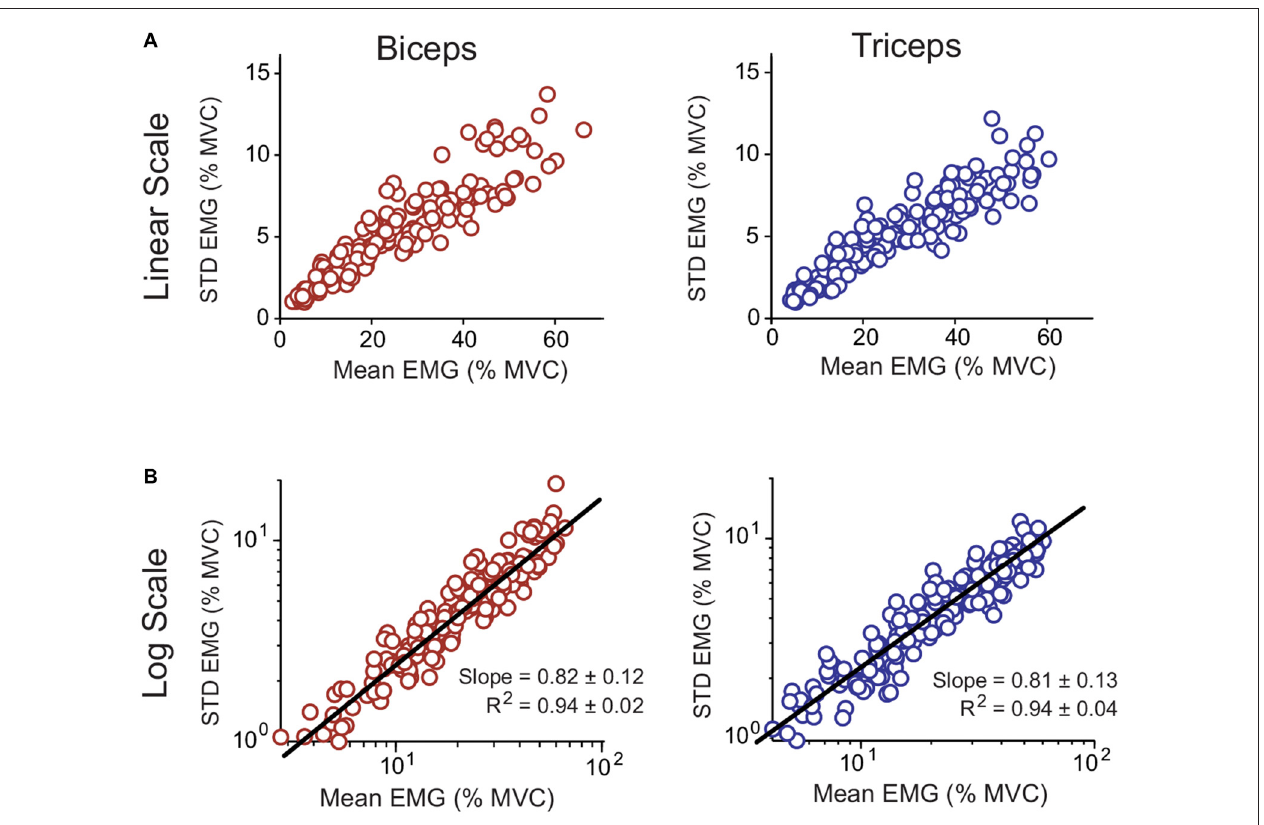
FIGURE 6 | Relation between the mean and STD of muscle linear envelopes recorded with surface electromyography (EMG) for the biceps and triceps. Data for all subjects and all isometric efforts are shown. The data are shown both on decimal ( A ; top row) and logarithmic ( B ; bottom row) scales. A line of best fit to the pooled data is shown for the logarithmically scaled data. The R 2 and slope values reported in (B) are for individual subject fits (mean ±